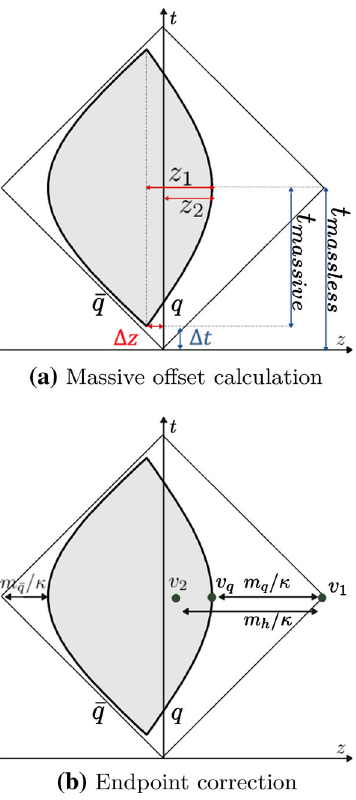
Fig. 13 Massive q ¯ q system and equivalent massless system. The grey area corresponds to the physical